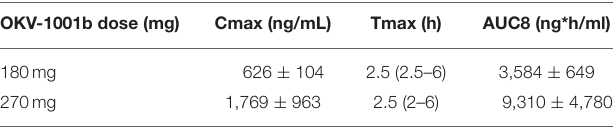
TABLE 1 | Steady-state (day 8) PK of 180mg and 270mg OKV-1001b in healthy beagle dogs. OKV-1001b dose (mg)